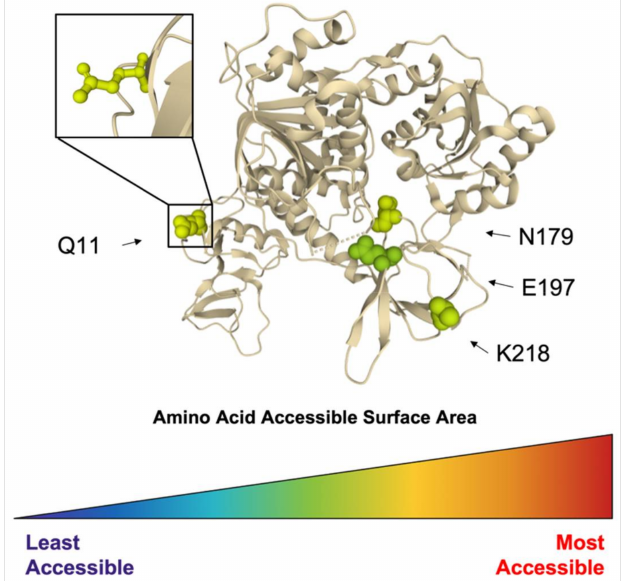
Figure 9. Conserved and accessible amino acids of CoV helicase. Identified conserved and accessible residues within coronavirus helicase highlighted with molecular surface representation and colored by amino acid ASA, ranging from the least accessible (dark blue) to the most accessible (red) in the Nsp13 crystal structure (PDB ID: 6ZSL). Four highly conserved residues are highlighted within the monomer by accessibility—Q11, N179, E197, and K21—with Q11 having the greatest